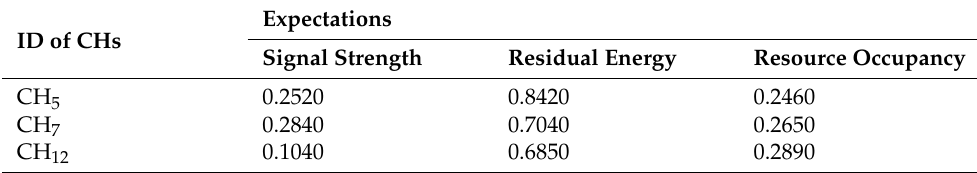
Table 1. Status statistics of